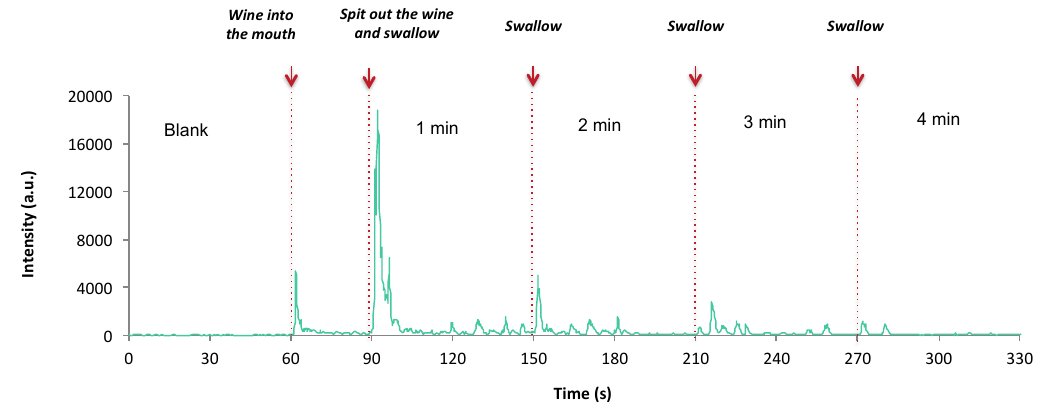
Figure 5. Example of oral aroma monitoring by PTR-ToF-MS.